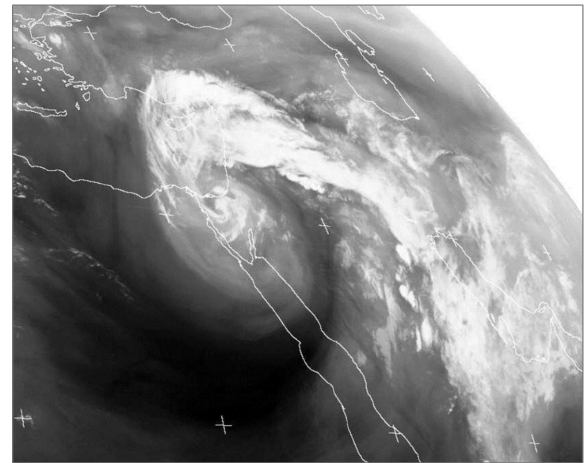
Figure 7. METEOSAT water vapour channel 6 (6.85–7.85µm) im- agery from 25 April 2018 21:00UTC showing the cloud strip en- tering Israel from the east and the vortex over the south-eastern